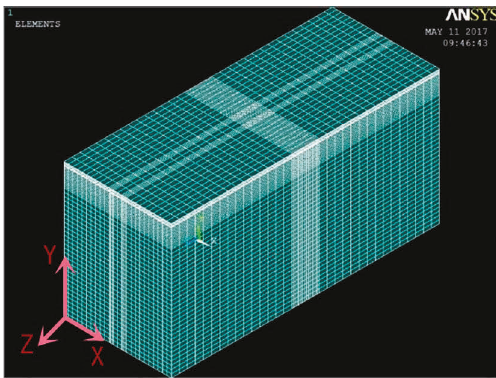
Figure 10: The FE model in this study. Table 3: Calculation results of T , DAF, and P traffic speeds.